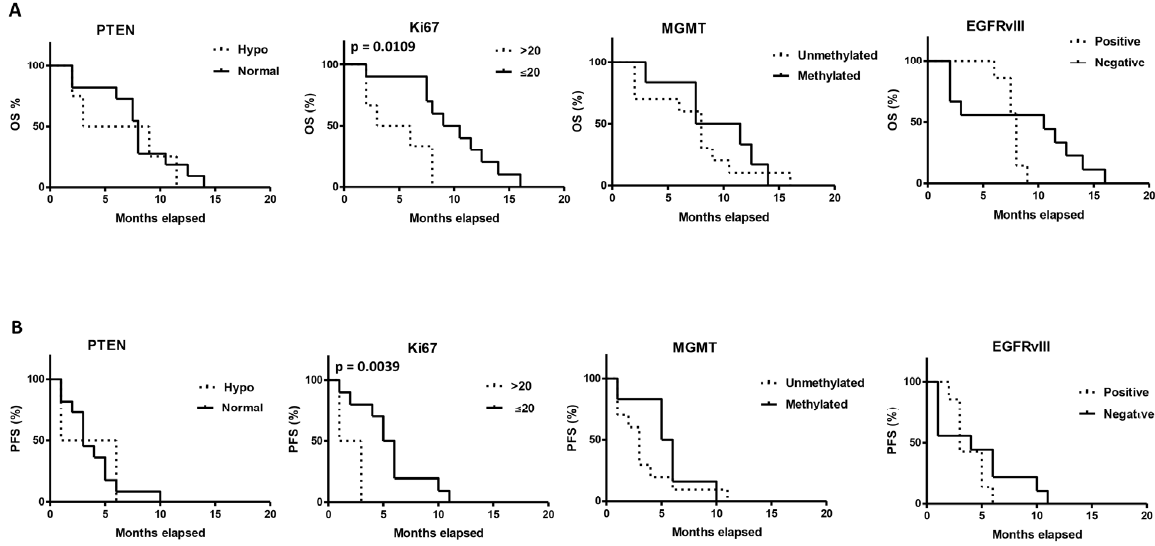
Figure 7. Survival analysis by Kaplan–Meier curves and long-rank (Mantel–Cox) test. The difference of OS ( A ) and PFS ( B ) in GBM patients stratified on the basis of PTEN status (hypophosphorylated/normal), Ki67 positivity, MGMT methylation status (unmethylated/methylated), and EGFRvIII